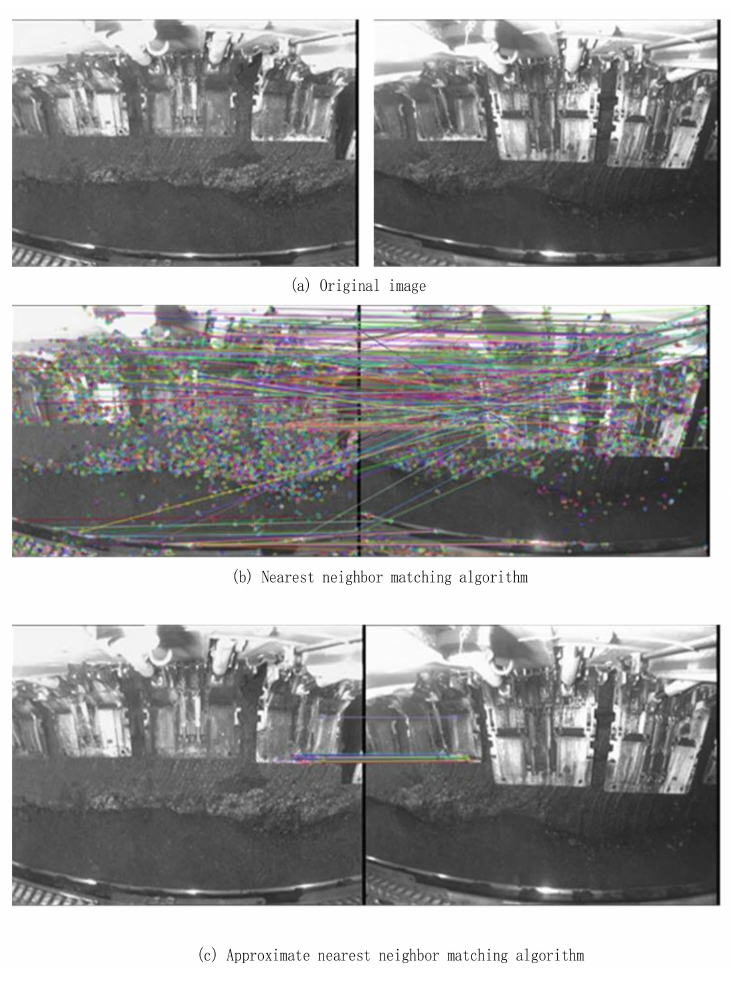
Figure 3. Results of coal mine image feature point registration: ( a ) original image, ( b ) nearest neighbor matching algorithms, and ( c ) approximate nearest neighbor matching